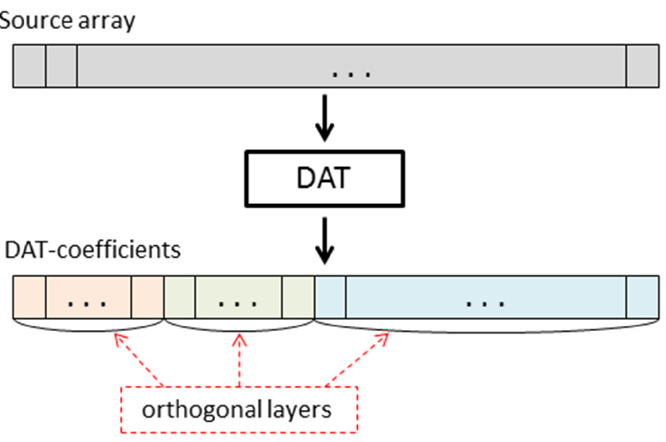
Figure 5. Discrete atomic transform of an array.